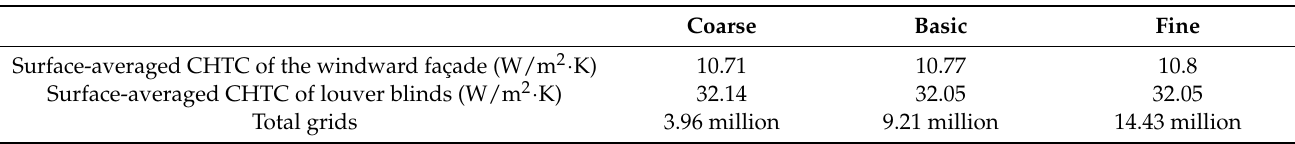
Figure 5. Mesh generation for grid independence analysis. Table 1. Predictions for CHTC avg by three different grid sizes ( B = 0.035 H , W = 0.05 H , θ = 45 ◦ , ϕ = 0 ◦